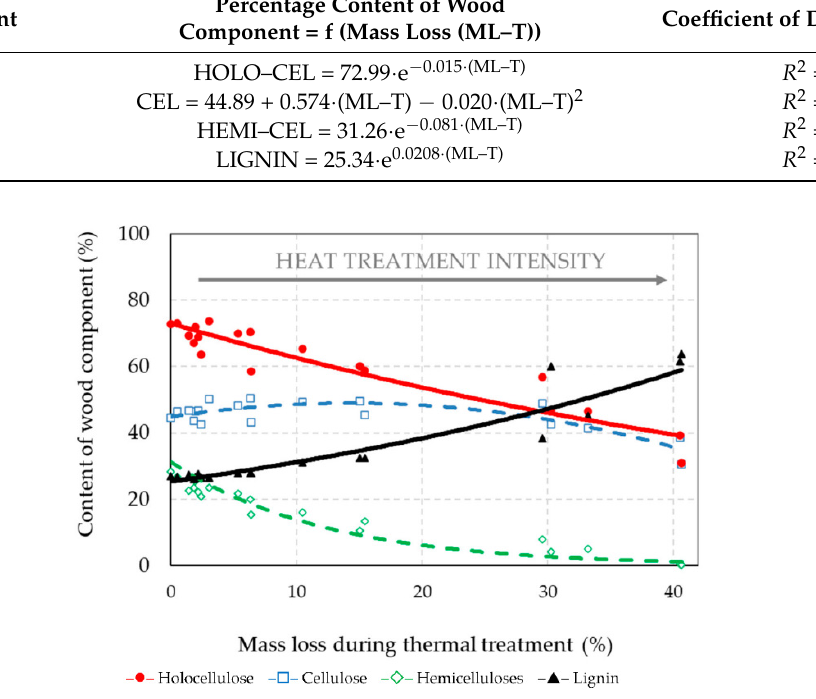
Figure 4. The percent content of wood components thermally treated spruce wood according to the mass loss during thermal treatment (Correlation equations are listed in Table 1). Table 1. Correlations between the content of wood components and the mass loss of the Norway spruce wood samples caused by thermal treatments.